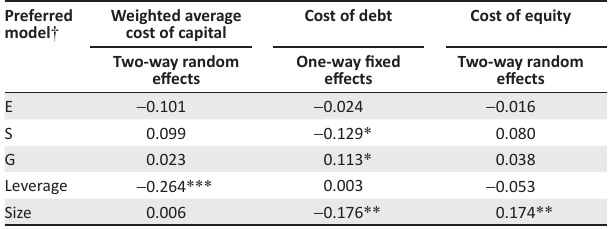
TABLE 2: Individual environmental, social and corporate governance disclosure regression results for sampled firms.